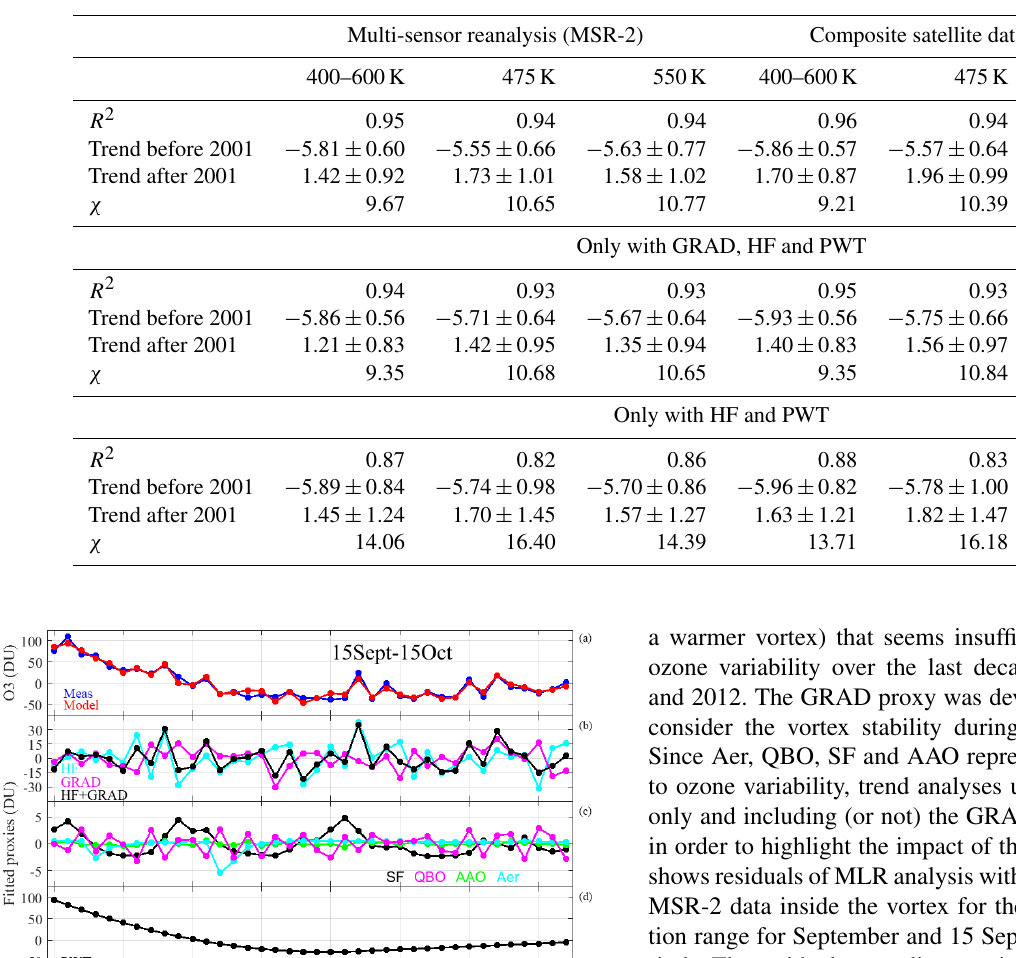
Table 3. Same as Table 2 but for 15 September–15 October period. SAT dataset is also presented.